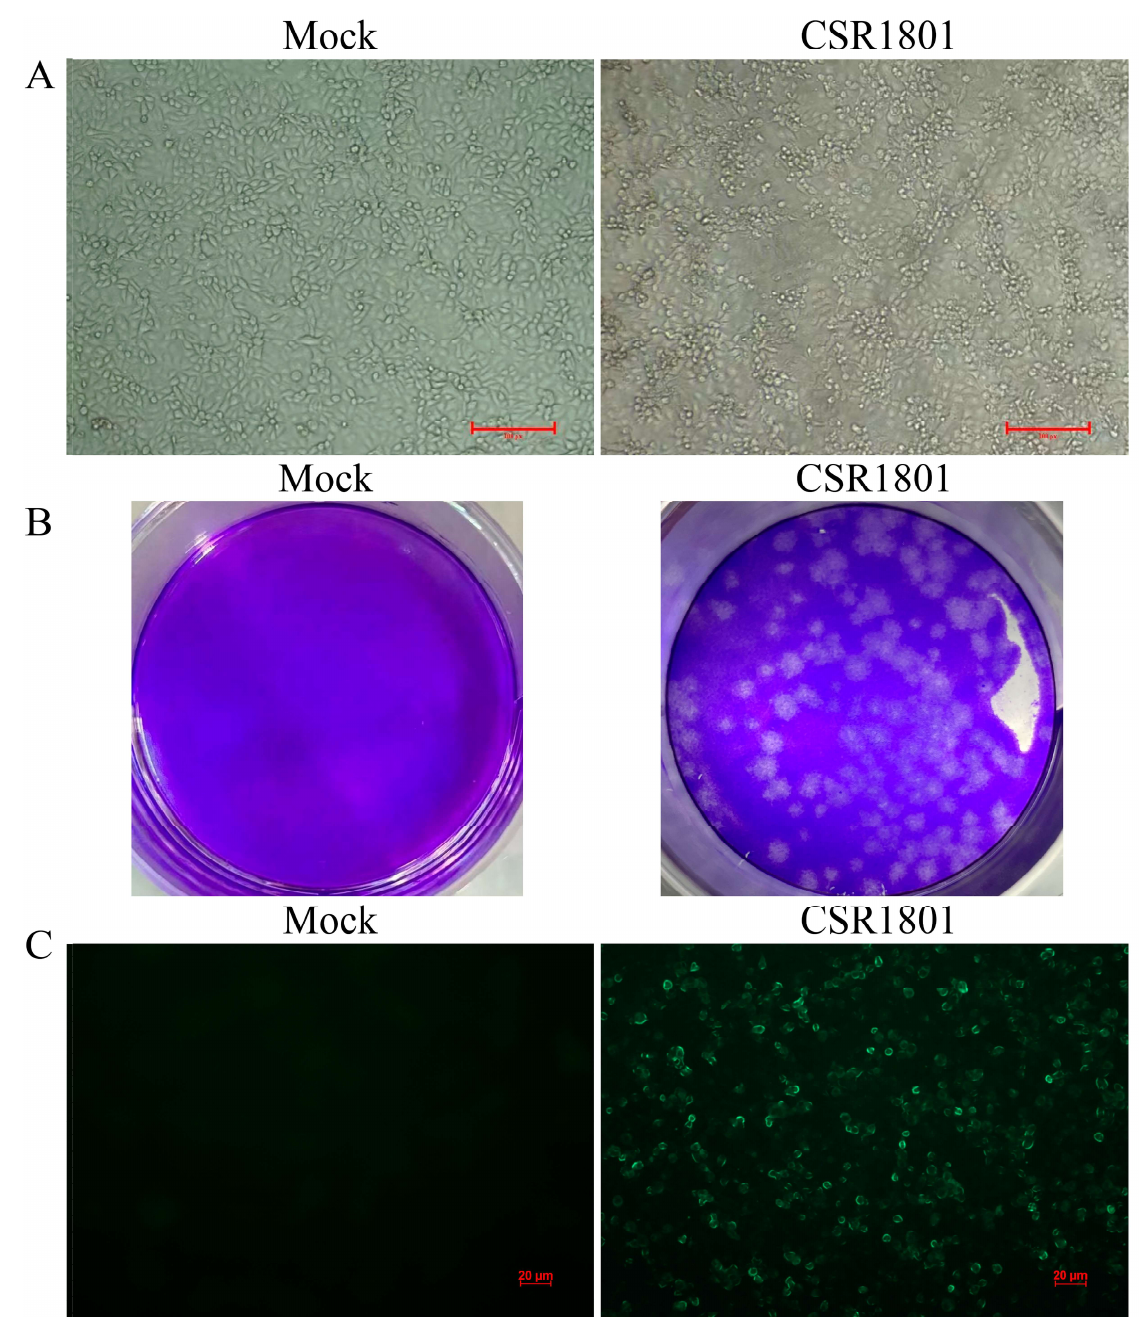
Figure 1. The isolation and identification of PRRSV strain CSR1801 by CPE, virus plaque, and IFA, respectively. ( A ) The typical CPE, including rounding, reduction and swelling in the cell, could be observed in the MARC-145 inoculated with the fourth generation of virus isolate. ( B ) The plaques were shown in plaque assay at the 500-fold dilution of the virus stock. ( C ) The PRRSV strain CSR1801 separated from the virus plaques was amplified and identified by immunofluorescence assay using the monoclonal antibody against PRRSV N